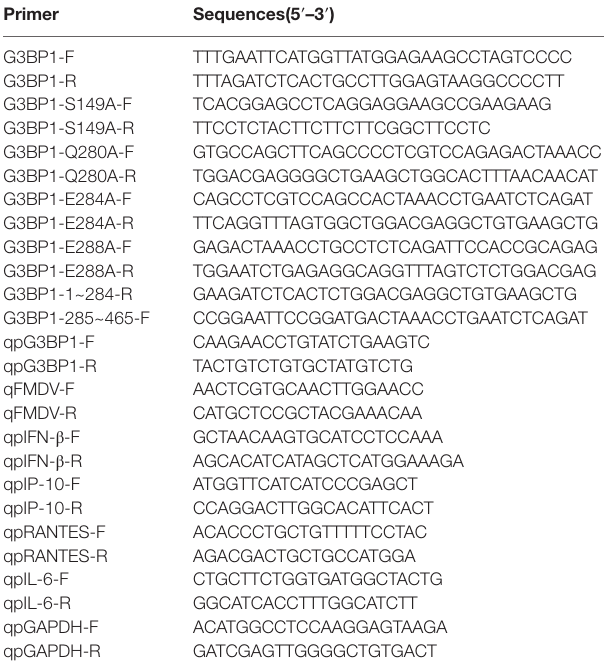
TaBle 1 | Primers used in this